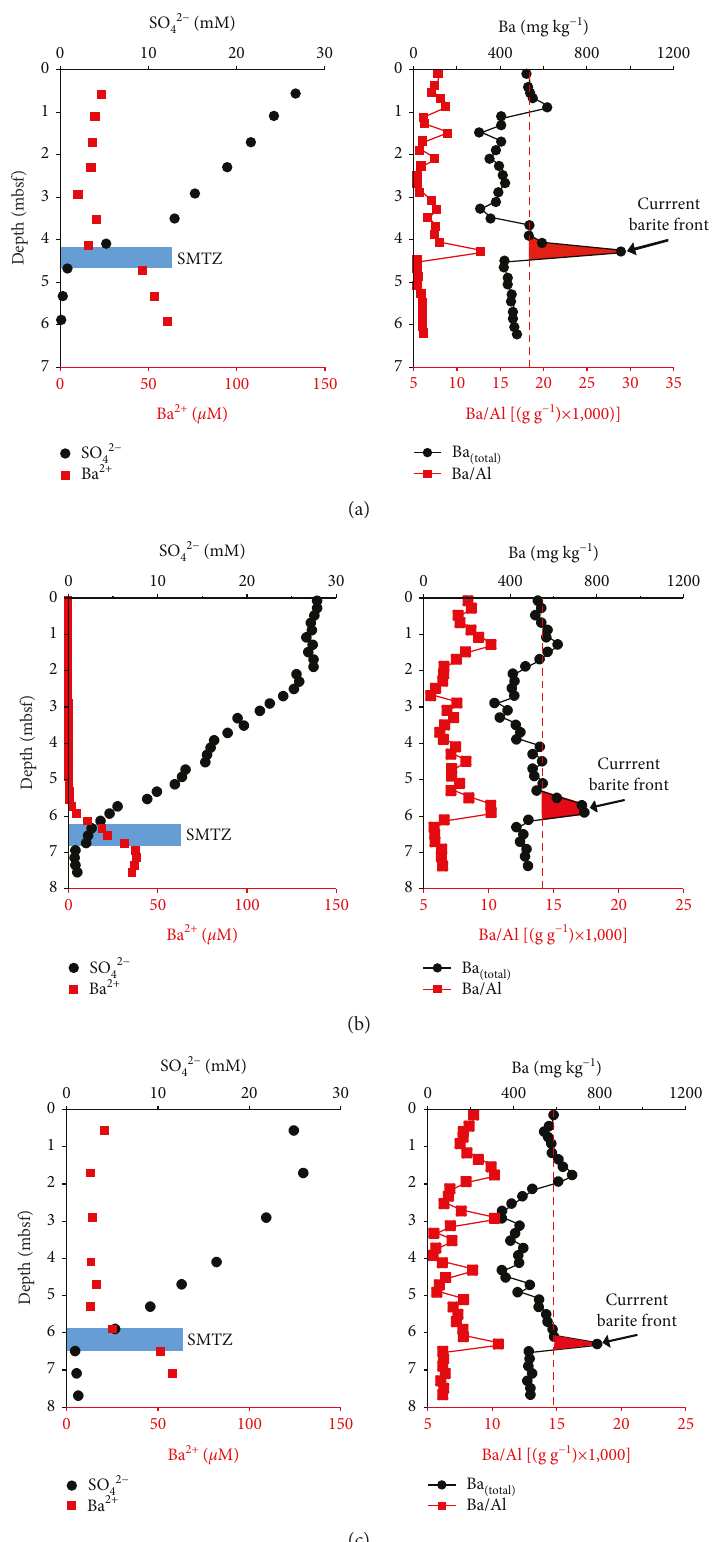
Figure 5: Concentration depth pro fi les of dissolved barium (Ba 2+ ), sulfate (SO 42- ), and solid-phase total barium (Ba ratios (Ba/Al), and diagenetic barium (shown as red peaks) for cores CL30 (a), CL44 (b), and CL47 (c). Blue bands mark the SMTZ. Pink dash lines indicate the background barium contents based on the distribution of barium content. Barium contents above background represent diagenetic barite enrichments (red